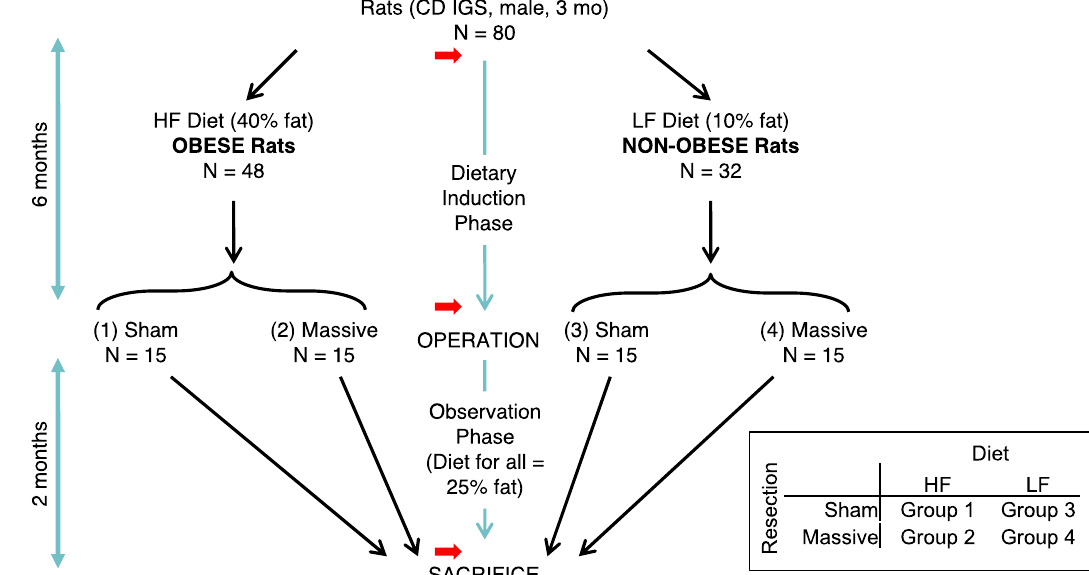
Figure 1. Experimental Design. HF = High-Fat; LF = Low-Fat; Sham = sham resection; Massive = 75% distal small intestinal resection. Red arrow = body composition measurement. Inset: 2 × 2 matrix of experimental